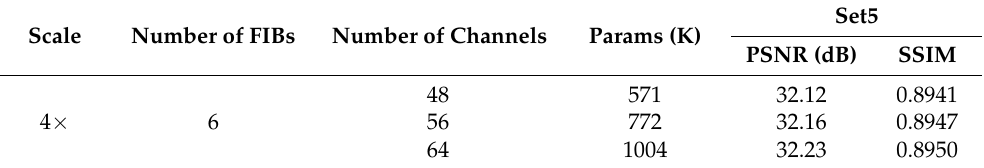
Table 2. The influence of the number of channels in the FIB on the model reconstruction effect.